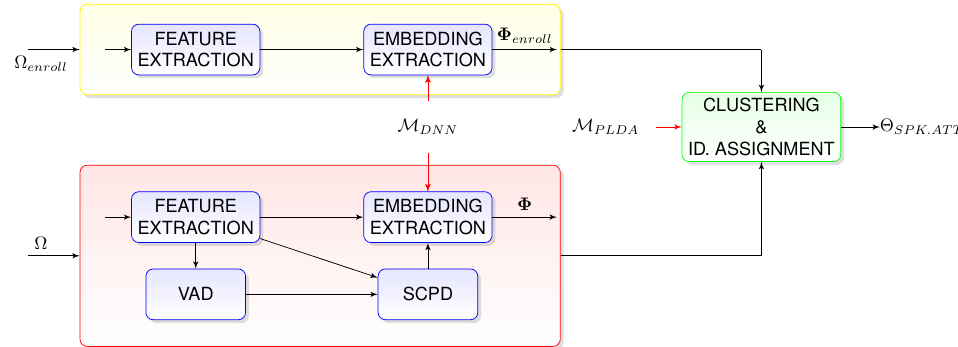
Figure 8. Flowchart for the hybrid approach. Red and yellow boxes, respectively, stand for the embedding extraction pipelines for the evaluation audio Ω (online) and the enrollment audios Ω enroll (offline). Both sets of embeddings are used in the new hybrid clustering and identity assign- ment